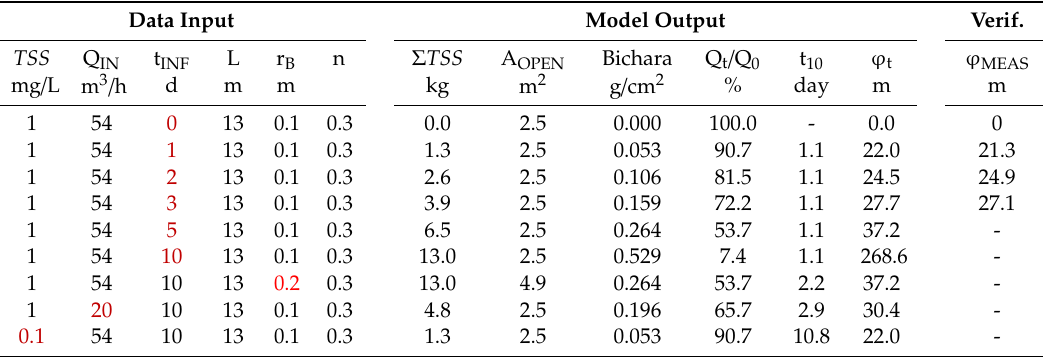
Table 6. Predicted flow reduction (Q t / Q 0 and Q 10 ) as function of injected particle mass ( Σ TSS = TSS Q IN t) and initial open area of external borehole wall (A OPEN ). Based on average linearized relation between Σ TSS / A OPEN and Q t / Q 0 trends in Bichara [26], see Section 2.6. t 10 = injection period needed to reduce flow by 10%. ϕ t , ϕ MEAS = the impressed head in the injection well as predicted and measured, respectively. Red numbers: significant scenario changes.